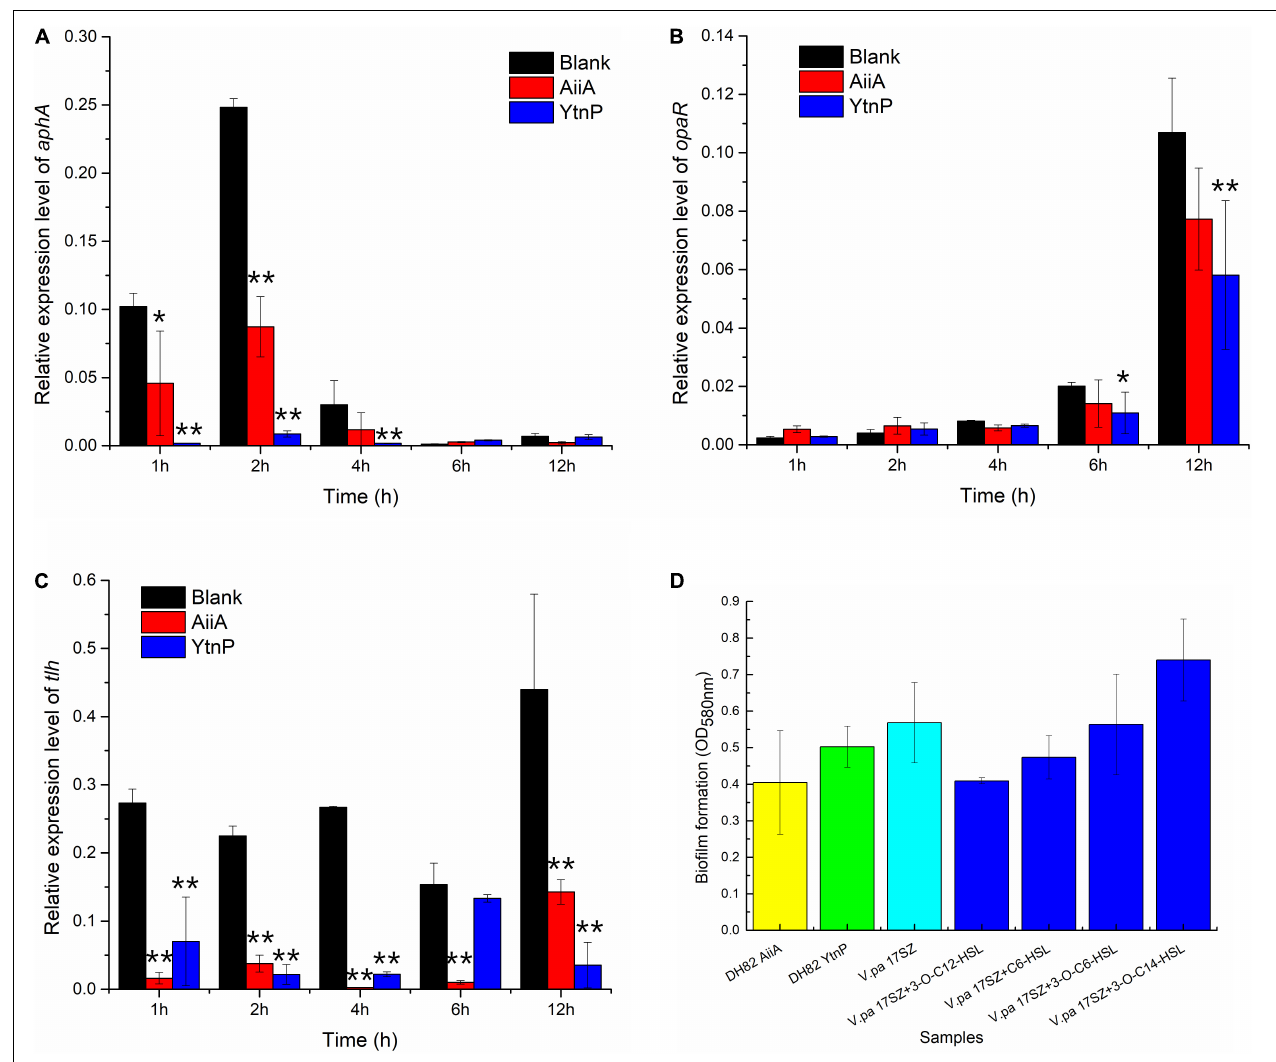
FIGURE 1 | Effect of quorum quenching (QQ) enzymes on the regulation of QS against Vibrio parahaemolyticus. Fifty microgram/milliliter QQ enzyme was used to treat the 17SZ culture [OD 600 0.1, 1:100 (v/v) inoculation] in LB at 30 ◦ C. RNA from bacterial culture sampled at 1, 2, 4, 6, and 12 h was used as temperate for RT-qPCR, using 16S rRNA as internal reference. Panel (A) is the effect on the expression of aphA ; Panel (B) is the effect on the expression of opaR; Panel (C) is the effect on the expression of tlh ; Panel (D) is the effect of QQ enzyme on biofilm formation of 17SZ. The error bars are presented as the standard deviation. Statistical analysis results are presented by a significant difference indicated by ** where p < 0.01 and * where p < 0.05.